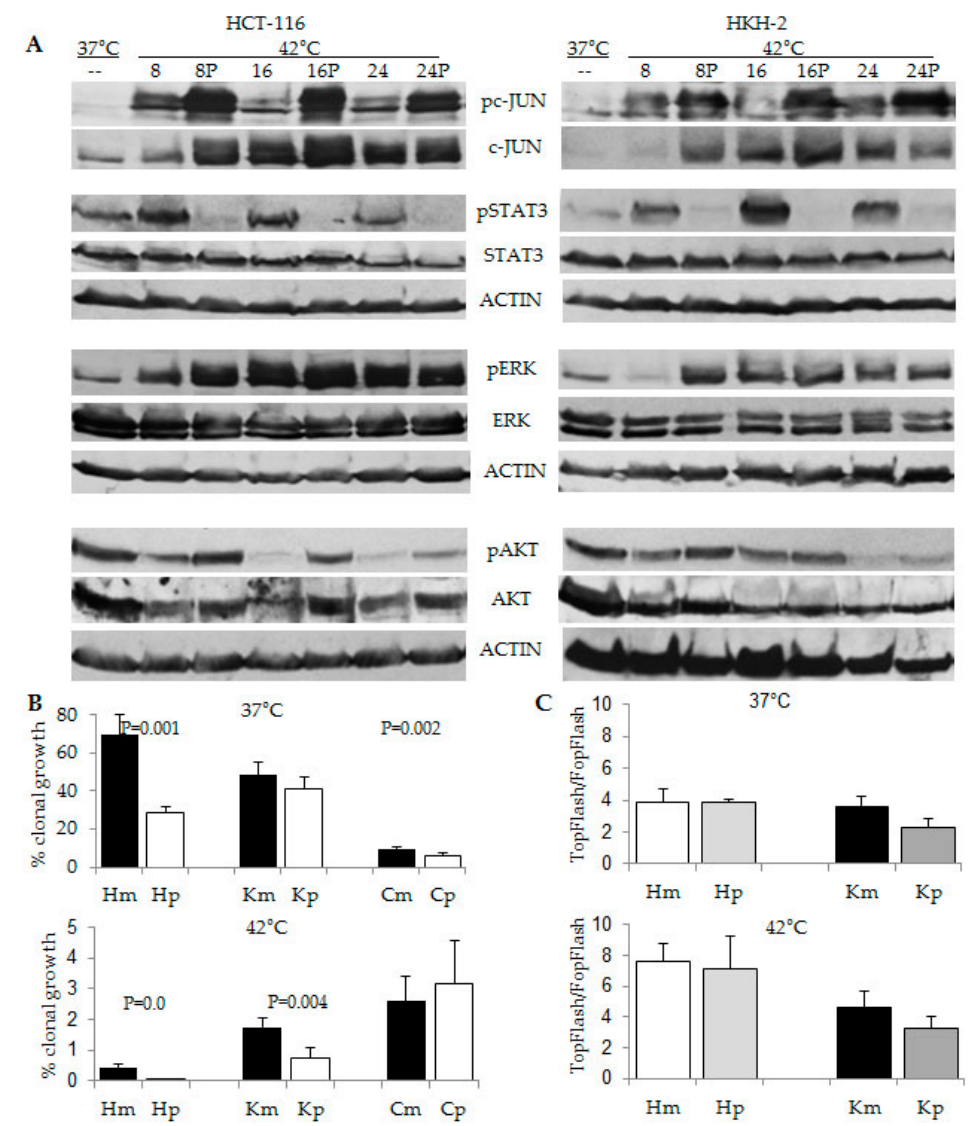
Figure 7. Combined effect of hyperthermia and propolis on CRC cells. ( A ) Representative Western blot analyses with total cell lysates after exposure of HCT ‐ 116 and HKH2 cells to 37 °C or 42 °C, for 8, 16, or 24 h in absence or presence of 100 μ g/ml propolis (P); ( B ) Clonal growth assays of HCT ‐ 116 (H), HKH2 (K) and CDC841CoN (C) cells were performed as described in the legend of Figure 1. Cells were exposed simultaneously for 24 h to 37 °C or 42 °C and to mock (m) treatment or propolis (p) at 100 μ g/mL. Results are the mean from minimum of four clonal growth assays with triplicate samples per treatment. Only statistically significant different values are indicated; ( C ) WNT/beta ‐ catenin transcriptional activity was measured with the luciferase reporter pair TOP ‐ Flash and FOP ‐ Flash as described in Materials and Methods. Mock and propolis treatment were performed for 16 h as in ( B ).